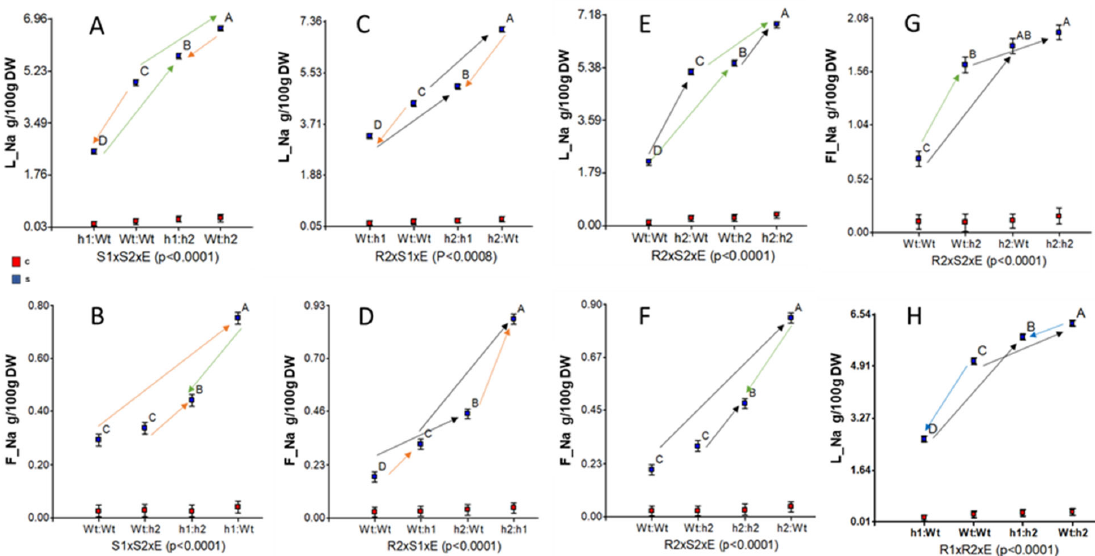
Figure 4. Graphical representation of triple interactions involving the salinity level for the Na content of leaf (L_Na, in A , C , E , and H ), fruit (F_Na, in B , D , and F ) and inflorescence (Fl_Na, in G ). S1 × S2 × E interactions in A and B. R2 × S1 × E interactions in C and D. R2 × S2 × E interactions in E, F and G. R1 × R2 × E interaction for L_Na in H. In all cases, no mean differences were found for control conditions (red squares). Arrows show the directions of the effects of silencing SgHKT1;1 at the scion (orange arrows) and at the root (blue arrows), and silencing SgHKT1;2 at the scion (green arrows) and at the root (black arrows). Means with different letters are significantly different at 5% level.